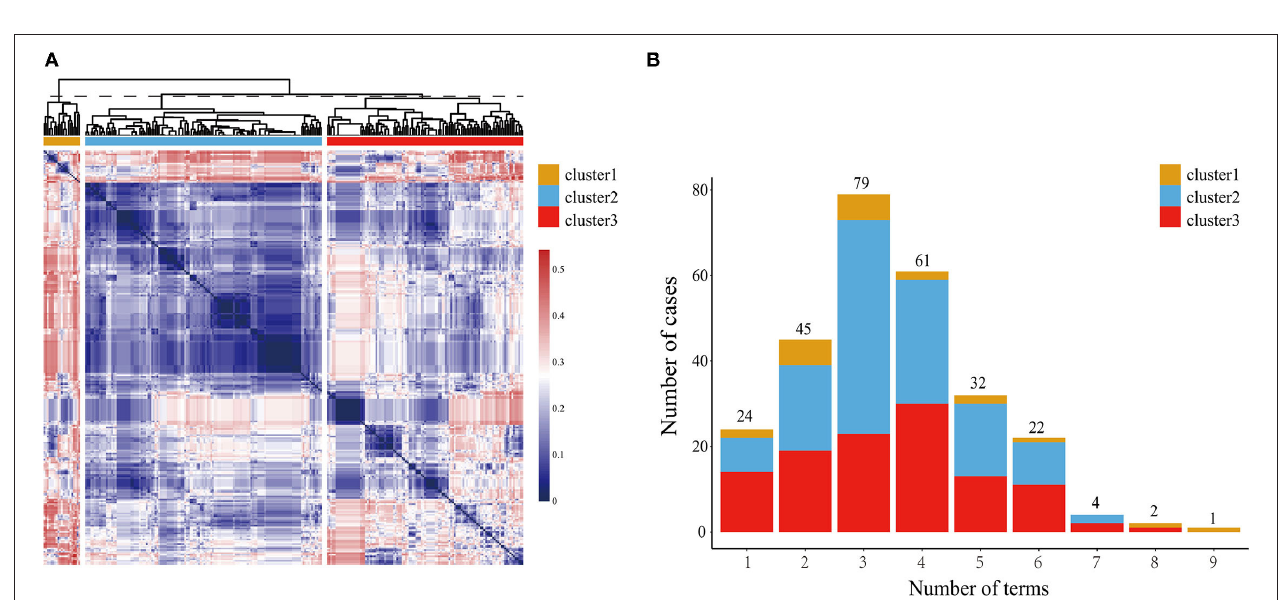
FIGURE 1 | HPO terms encoded for the ccTGA-associated cardiovascular anomalies. The tree plot shows the relationship of all the annotated phenotypes. Circles with borders are the phenotypes presented in our cohort (the phenotypes absent in the HPO database are not shown). The shade of the color represents the frequency of terms in the HPO database (the darker the color, the higher the frequency, with the color key on the top). Arrows indicate the relationship of affiliation between phenotypes. HPO, the human phenotype ontology; ccTGA, congenitally corrected transposition of the great arteries.